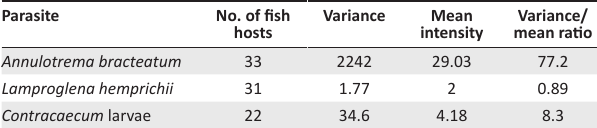
TABLE 6: Levels of aggregation of parasites on Hydrocynus vittatus. Parasite No. of fish